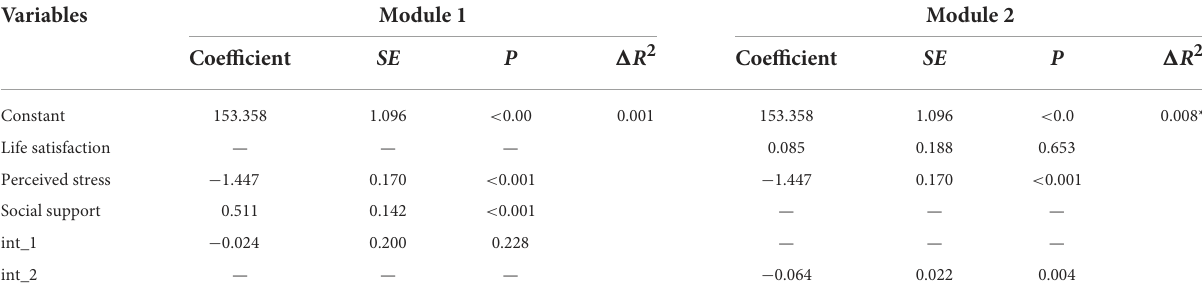
TABLE 4 The moderating effect of life satisfaction and social support between perceived stress and humanistic care ability.